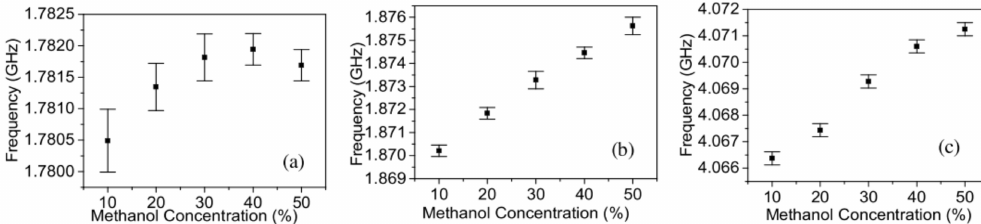
Figure 11. The results, which show the limit of detection for the proposed sensors, based on the CSRR ( a ), EX-SRR ( b ) and Circular SRR ( c ) [98]. Reprinted from Sharafadinzadeh, N.; Abdolrazzaghi, M.; Daneshmand, M. Investigation on planar microwave sensors with enhanced sensitivity from microfluidic integration. Sensors Actuators, A Phys. 2020 , 301 , 111752, doi:10.1016/j.sna.2019.111752 with permission from Elsevier.